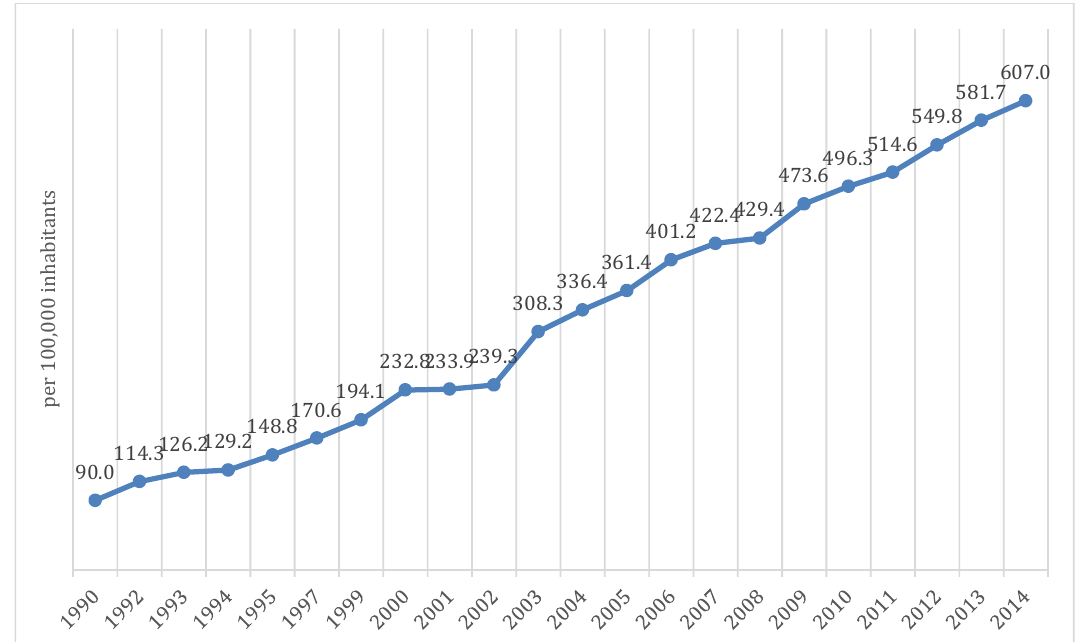
Figure 4: Growth of incarceration in Brazil, in absolute numbers (per 100,000 inhabitants),